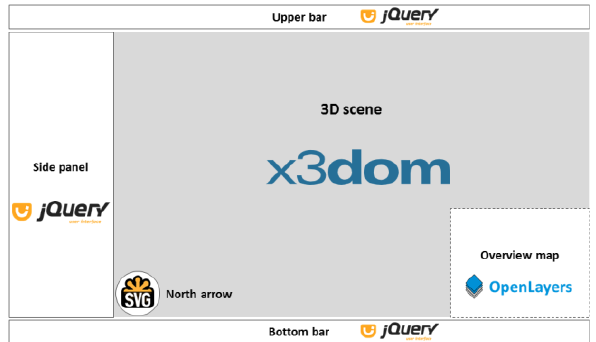
Figure 2. Proposal of layout of developed application The proposal for the layout is shown in Fig. 2 and is formed by the upper bar, the side panel, the bottom bar, and the 3D scene. The upper bar contains various function buttons. The side panel lists layers with the legend, predefined views, and the setting of the 3Dscene. Individual features represent HTML elements